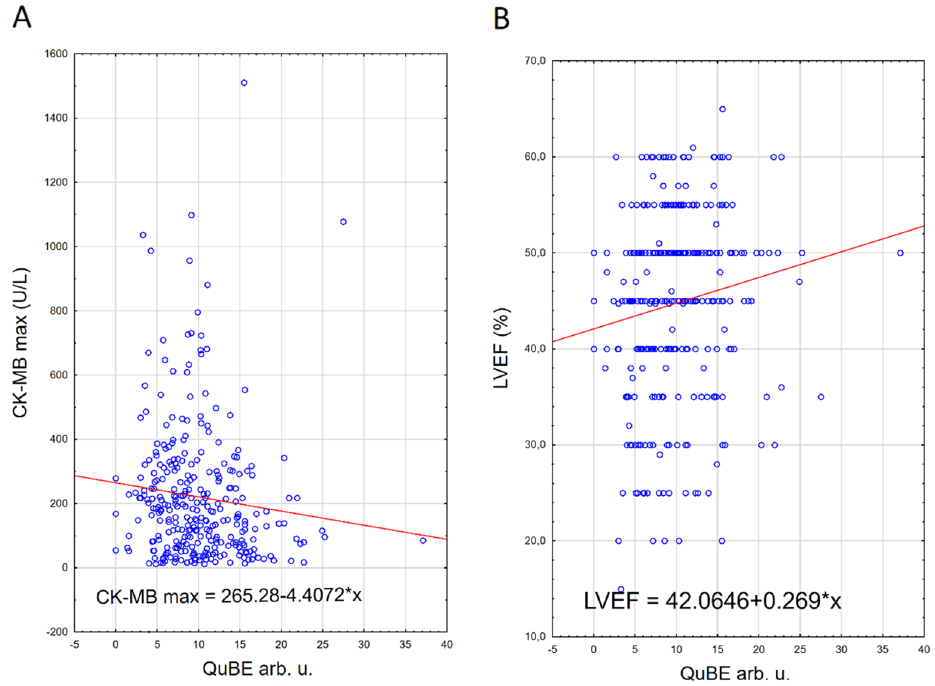
Figure 2. Graphical presentation of the relationship between peak CK-MB activity and QuBE ( A ) as well as LVEF and QuBE ( B ) in nondiabetic